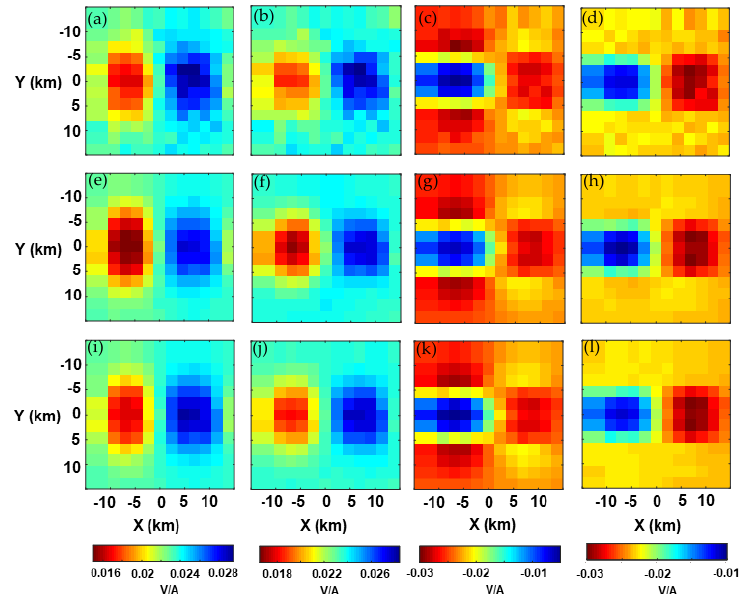
Figure 14. Data fitting for Z xy and Z yx components at the frequency of 0.46 Hz. Panels ( a ) and ( b ) show the real and imaginary parts of observed Z xy component. Panels ( c ) and ( d ) show the real and imaginary parts of observed Z yx component. Panels ( e ) and ( f ) show the real and imaginary parts of predicted Z xy component for isotropic inversion. Panels ( g ) and ( h ) show the real and imaginary parts of predicted Z yx component for isotropic inversion. Panels ( i ) and ( j ) show the real and imaginary parts of predicted Z xy component for anisotropic inversion. Panels ( k ) and ( l ) show the real and imaginary parts of predicted Z yx component for anisotropic inversion.